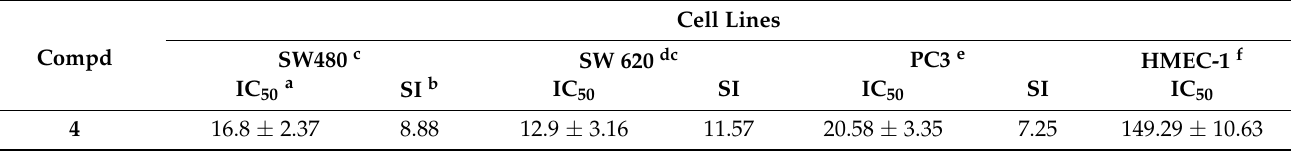
Table 2. Tumor-targeting selectivity of compound 4. Data are expressed as the mean ± SD.